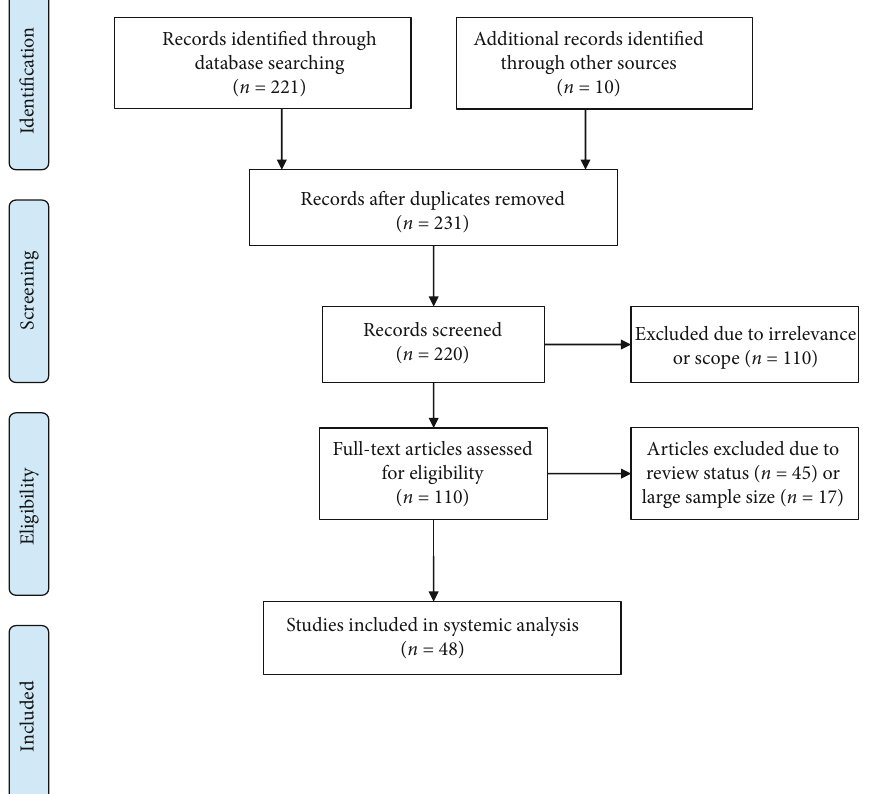
Figure 1: Search strategy fl